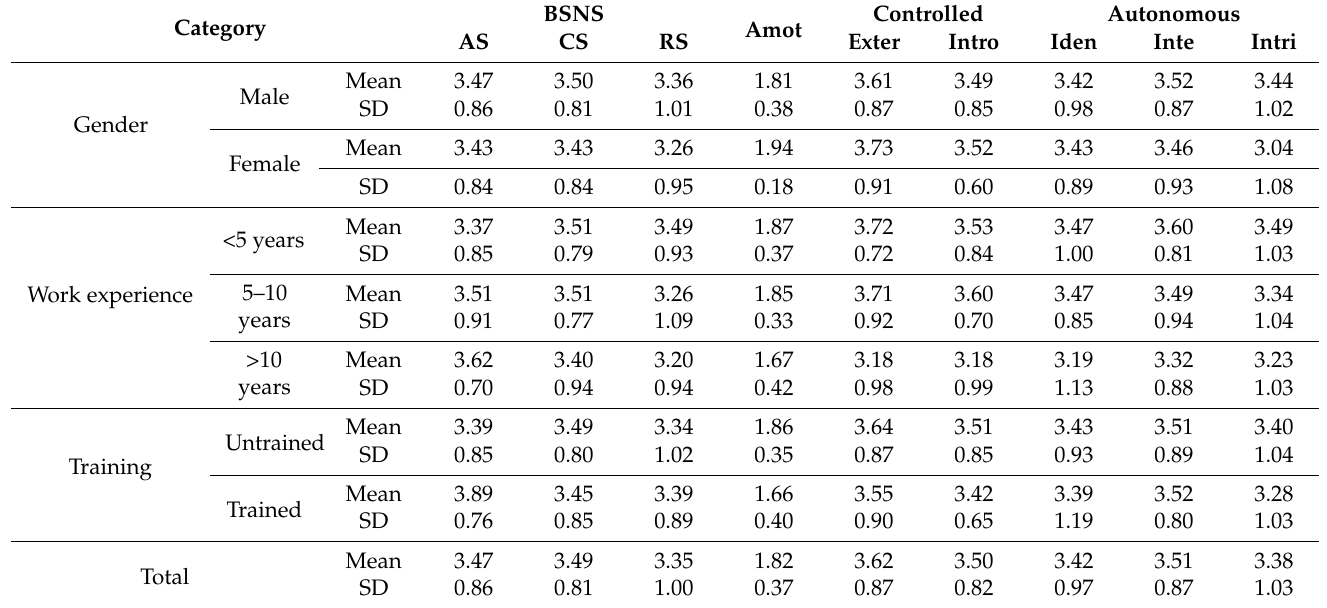
Table A4. Means and standard deviations of basic psychological needs and motivational subscales.